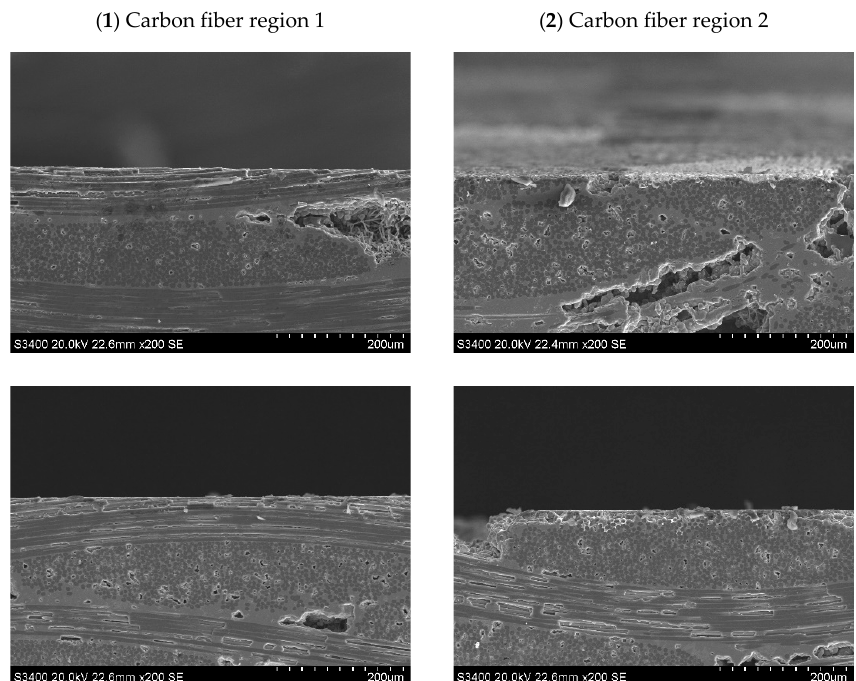
Figure 23. Subsurface morphologies of the C/SiC composite material after common grinding and ultrasonic vibration-assisted grinding(v s = 12.6 m/s, v w = 100 mm/min, a p = 0.1 mm).